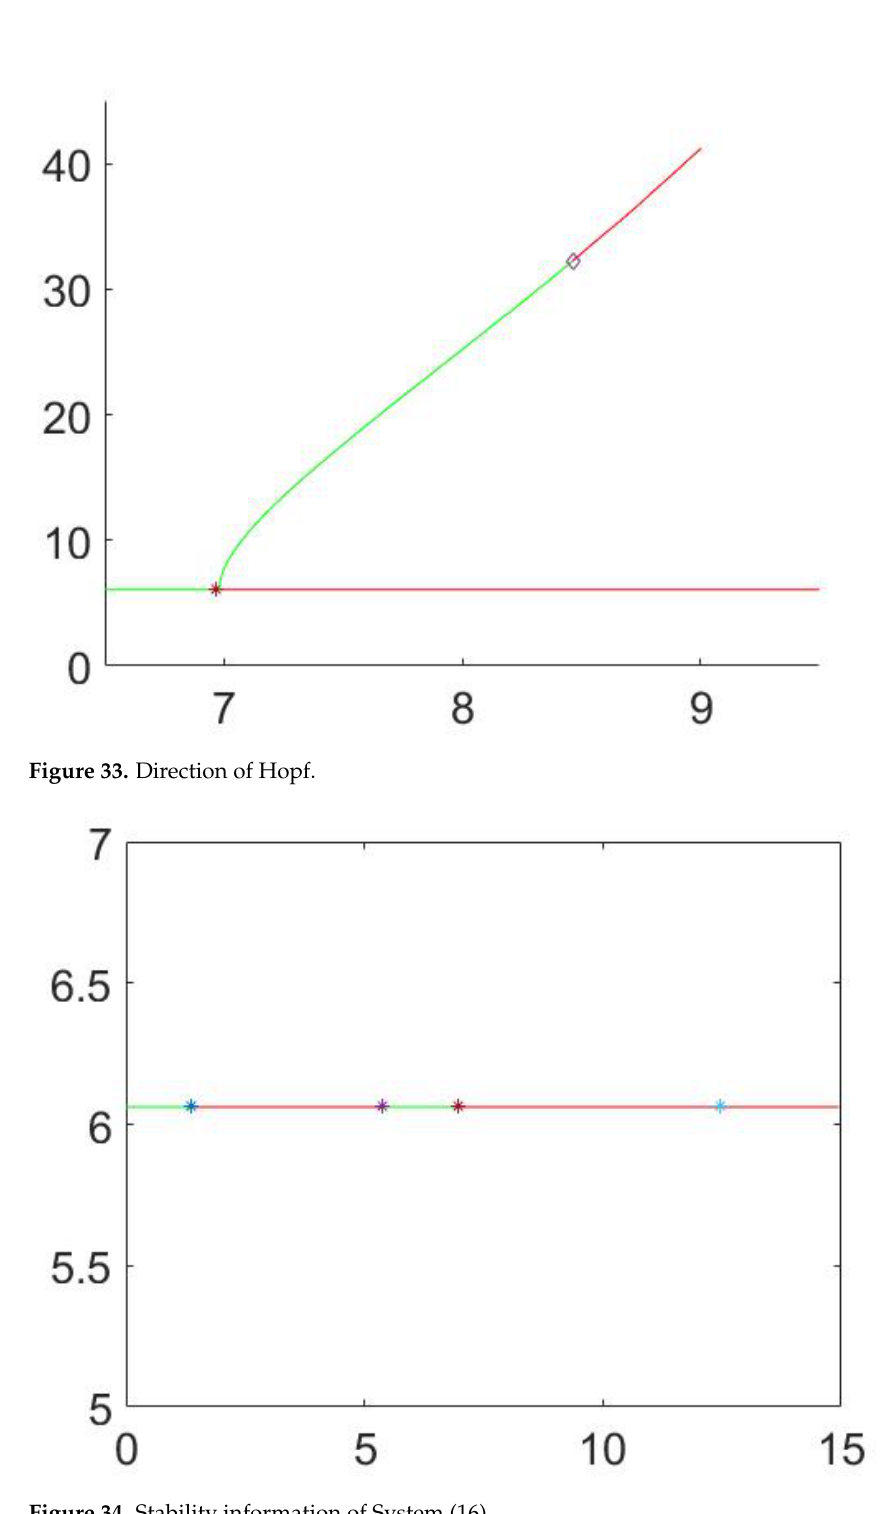
Figure 34. Stability information of System